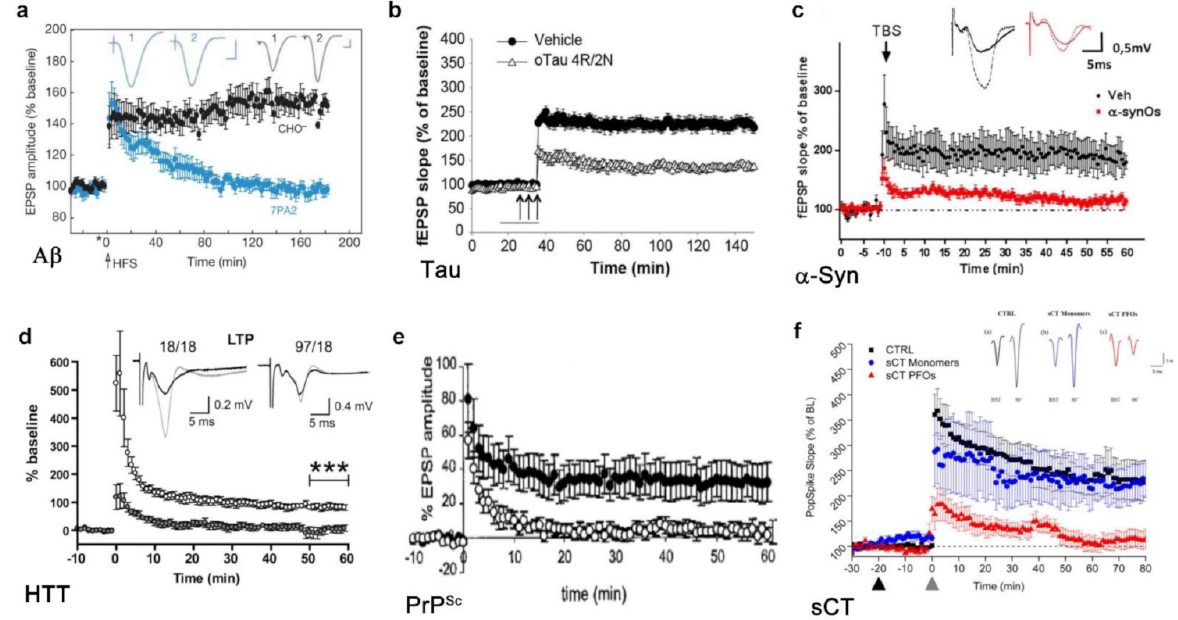
Figure 3. Reduction in LTP observed in models for the study of the amyloid neurotoxicity. ( a ) Alzheimer’s disease: microinjection of A β oligomers (blue) strongly reduced hippocampal LTP compared to control (black) (with the courtesy of Walsh et al. [178]); ( b ) Alzheimer’s disease: perfusion with tau oligomers (white) impairs LTP in mouse hippocampal slices (with the courtesy of F á et al. [179]); ( c ) Parkinson’s disease: α -syn oligomers (red) reduce LTP in the CA1 region in mouse hippocampal slices (with the courtesy of La Vitola et al. [180]); ( d ) Huntington’s disease: hippocampal LTP recorded in the CA1 region of hippocampal slices from 9-month-old Hu97/18 model mice (black) is significantly reduced compared with that of animals of the same age (white) (with the courtesy of Kolodziejczyk et al. [177]); ( e ) prion disease: mice infected with scrapie ME7 shows a strongly reduced LTP in the CA1 area (white) (with the courtesy of Johnston et al. [181]); ( f ) amyloid model: treatment with sCT PFOs (red) results in impairment of LTP in mouse hippocampal slices while slices treated with monomeric sCT (blue) show no significant changes compared to control (black) (with the courtesy of Belfiore et al.